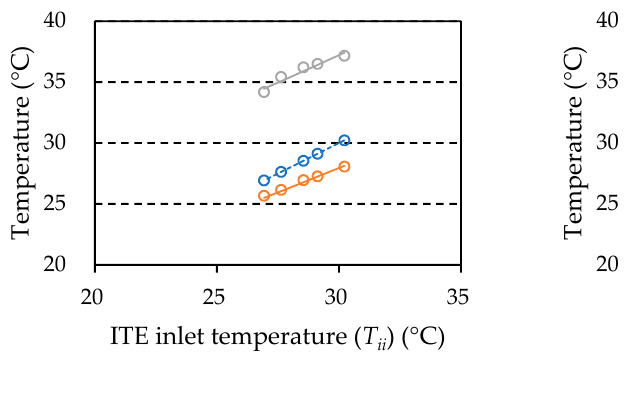
Tci (prediction) Figure 13.